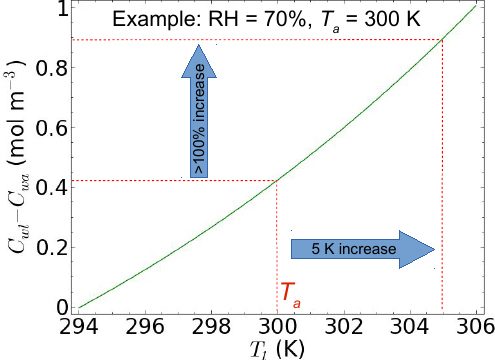
Figure 1. Dependence of the leaf-air water vapour concentration difference ( C wl − C wa ) on leaf temperature ( T l ). In this example (70% relative humidity, 300K air temperature ( T a )), the water vapour concentration difference doubles for an increase in leaf tem- perature by 5K relative to air temperature, or drops to 0 for a de- crease in leaf temperature by 6K.